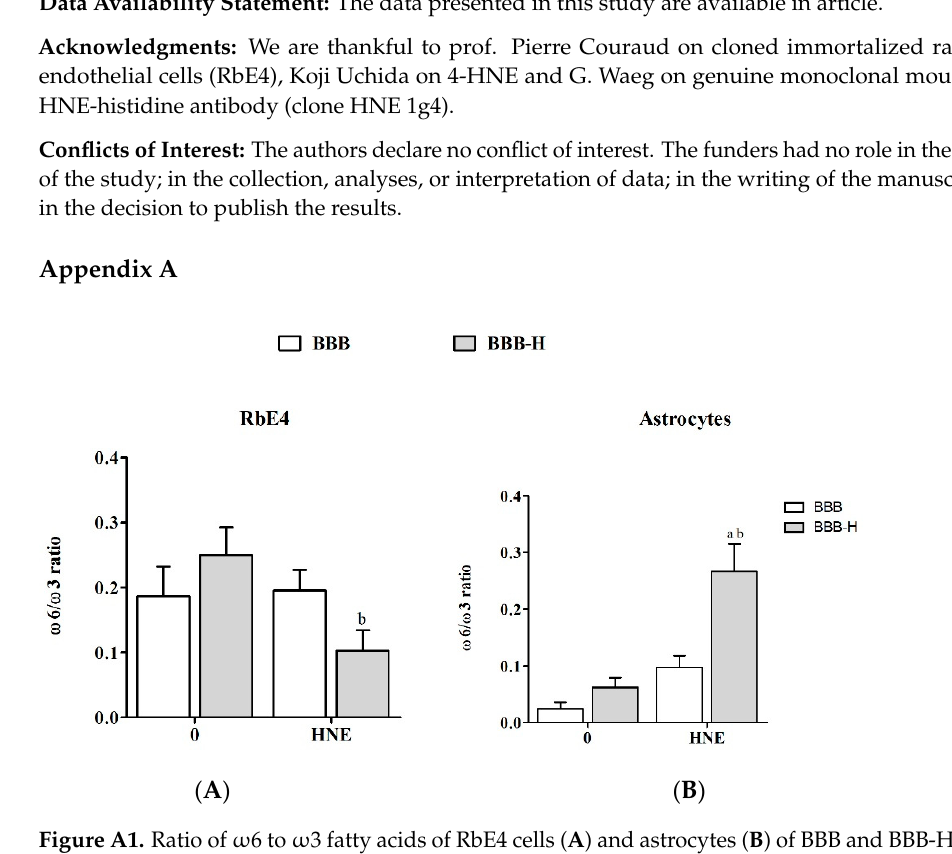
Figure A1. Ratio of ω 6 to ω 3 fatty acids of RbE4 cells ( A ) and astrocytes ( B ) of BBB and BBB-H model at control conditions (0) and 20 µM HNE treatment. All results are represented as mean ± SEM, n = 4 samples for each group from 2 independent experiments. a—statistically significant in respect to control (0) on pure collagen, p < 0.05; b—statistically significant in respect to control (0) on modified collagen, p < 0.01.